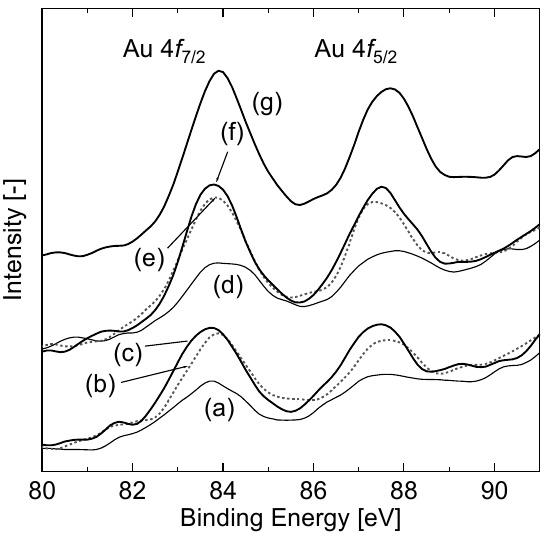
Figure 6. Au 4 f spectra of the catalysts reduced at 140 °C by ( a ) CO; ( b ) H reduced at 200 °C by ( d ) CO; ( e ) H WGS at 80